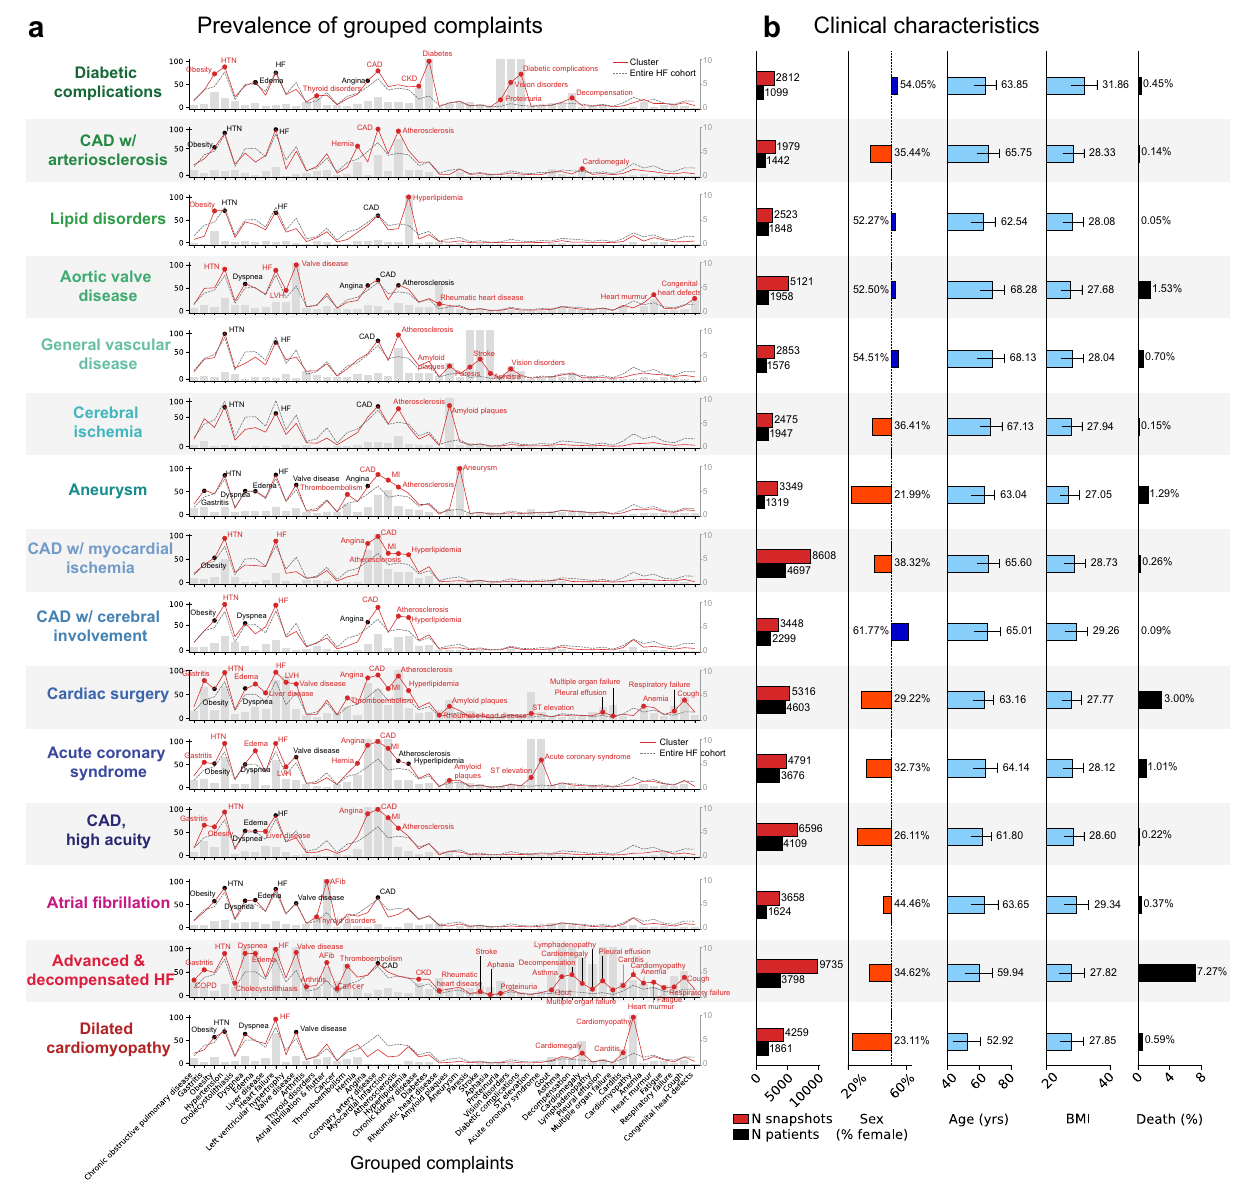
Figure 3. ( a ) The prevalence of various grouped complaints per cluster disease state. Traces in red show the prevalence (%) of the grouped complaints within the cluster, while the dotted gray line shows the prevalence in the entire cohort. Gray bars indicate the odds ratio of the grouped complaint occurring within the cluster. Complaint groups with an odds ratio > 2 within the disease state cluster are marked with a red circle and the text of the complaint. Complaint groups with an odds ratio < 2 but a prevalence > 50% within the disease state cluster are shown with a black circle and the text of the complaint. ( b ) Clinical characteristics of disease state